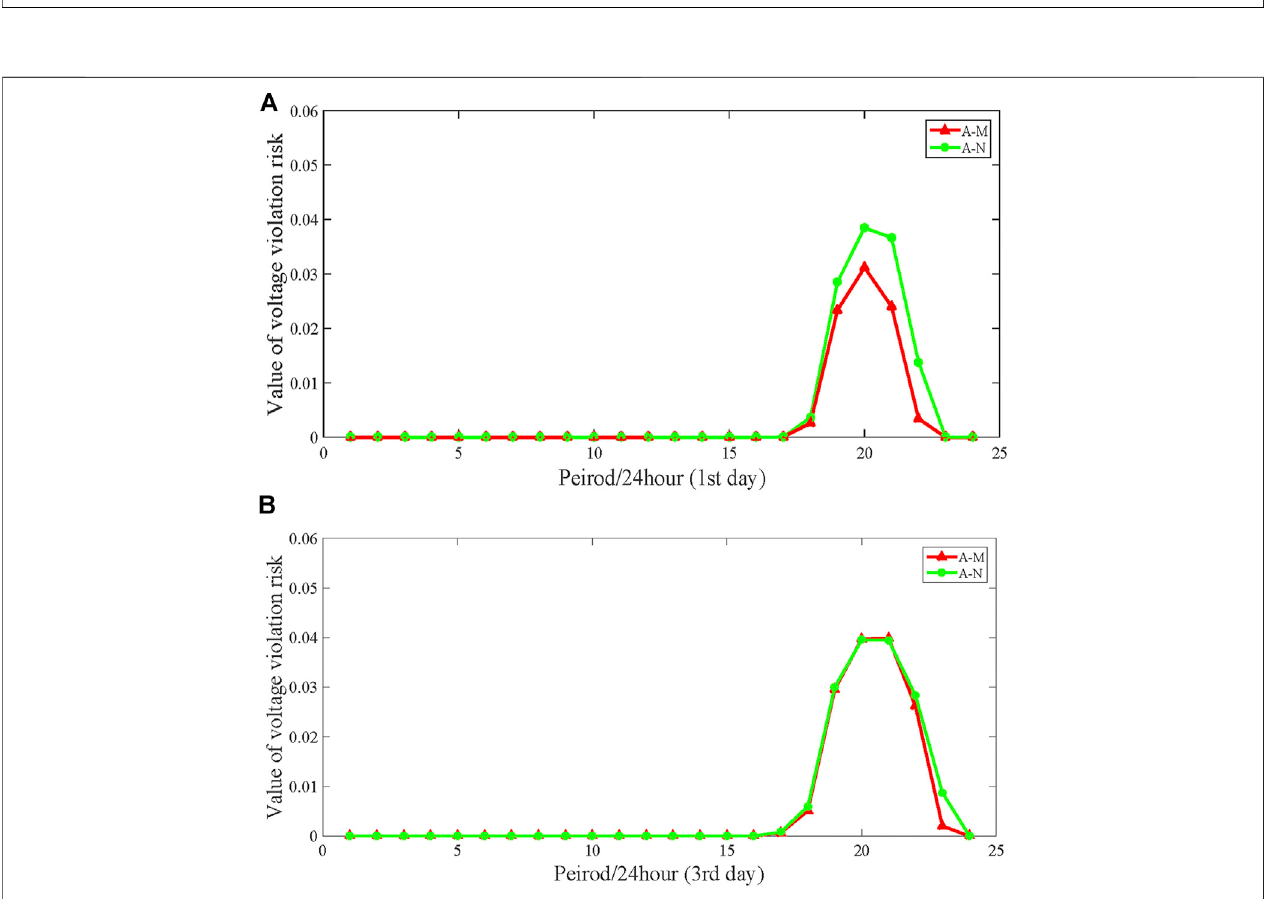
FIGURE 12 | Comparison of the voltage violation risk of node 15 for different attack durations. (A) First 24 h (1 st day). (B) Third 24 h (3 rd day).